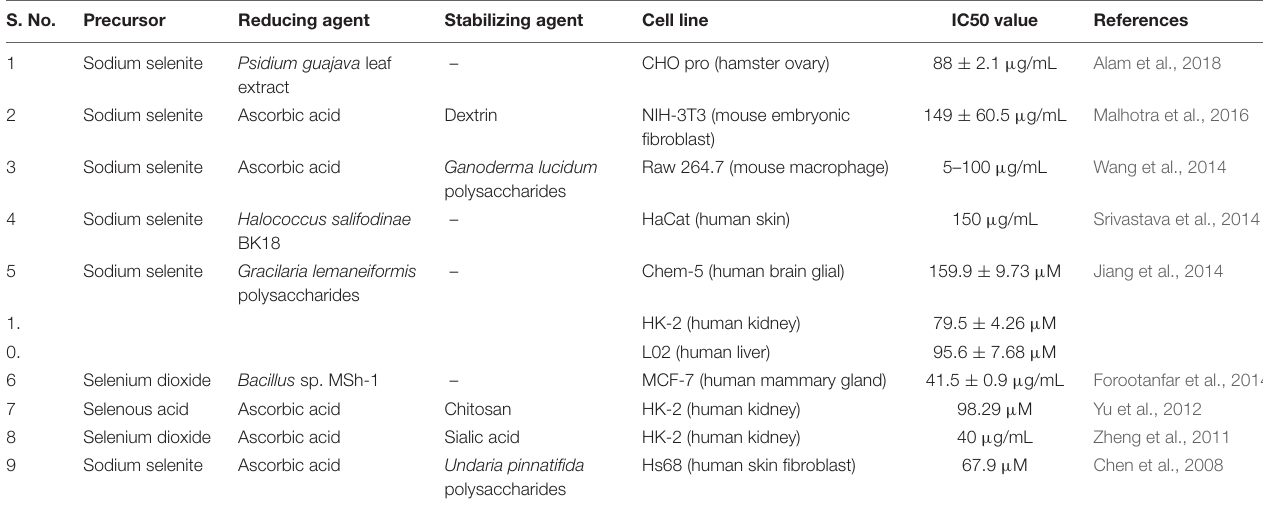
FIGURE 12 | Rhodamine 123 stained images depicting mitochondrial membrane potential (MMP) of N2a cells treated with 150 µ M of H 2 O 2 and different dose of sodium selenite and phytofabricated selenium nanoparticles (PF-SeNPs) for 24 h. The scale bar is 100 µ m. TABLE 2 | Overview of in vitro cytotoxicity of selenium nanoparticles (SeNPs) on different cell lines. S.